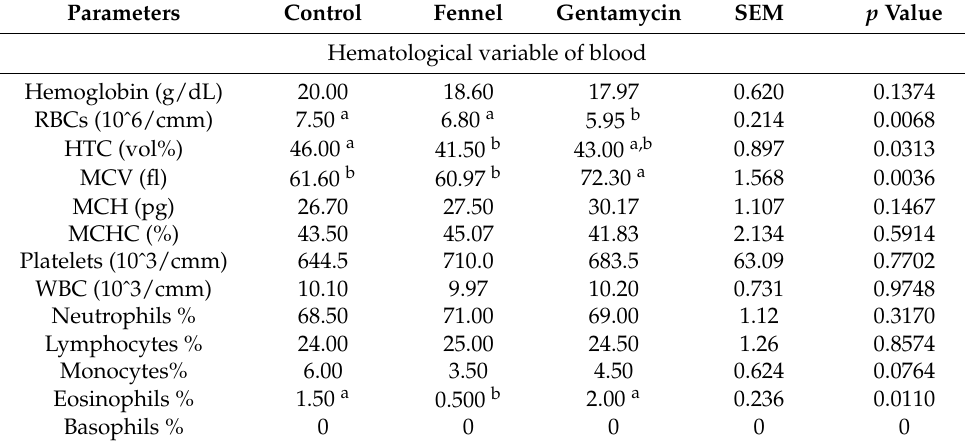
Table 6. Impact of dietary fennel oil or gentamycin on hematological variable of blood serum of weaned Moshtohor rabbits aged 12 weeks.